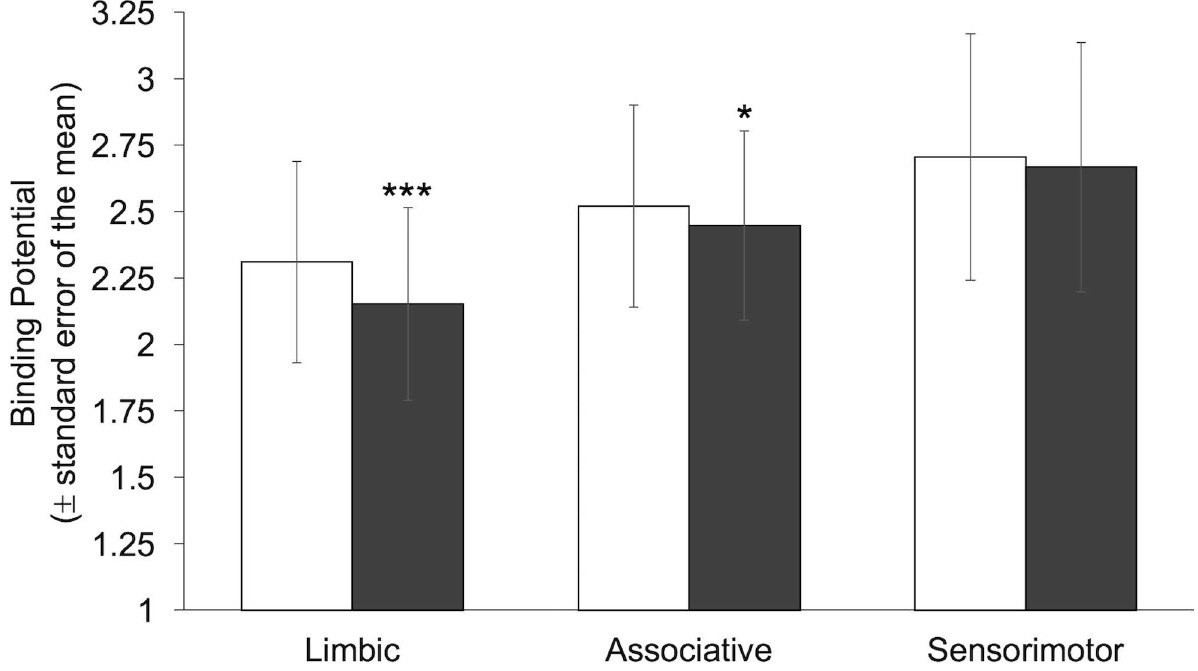
Fig 1. Striatal binding potentials. Mean bindingpotentials (BP ND ± standarderror of the mean) in the limbic, associative and sensorimotor striatum with (grey) and without (white) amphetamine ( *** p < .001, * p < .05).